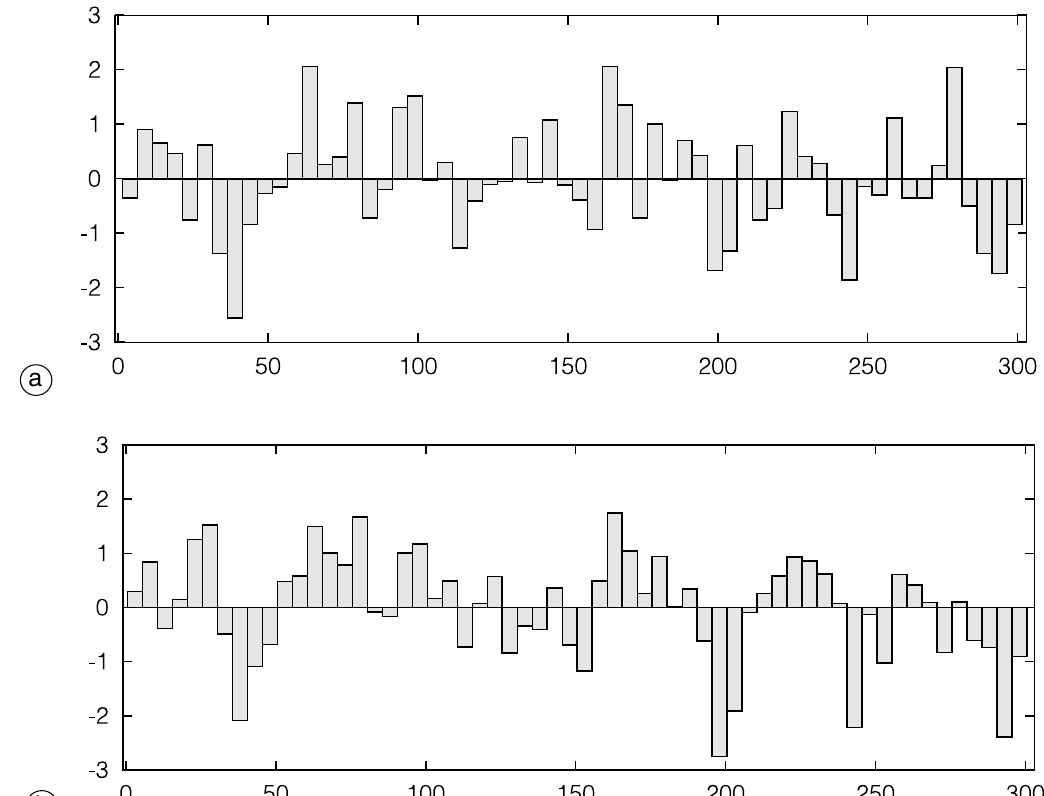
Fig. 10a,b. Standardised time series for the patterns in fig. 9a,b. a) For Atlantic/European MSLP; b) for Atlantic SST. Correlation coefficient between time series is